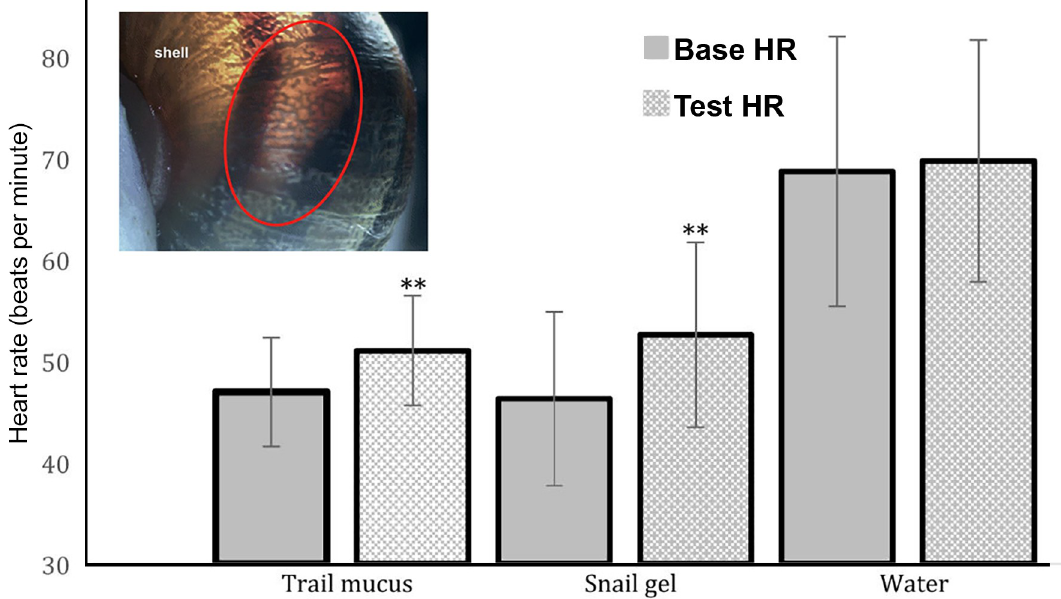
Fig 1. Mean heart rate before and after exposure to trail mucus, snail gel and water. �� indicates significant difference ( p < 0.05) using a repeated-measures t -test between base and test heart rate.